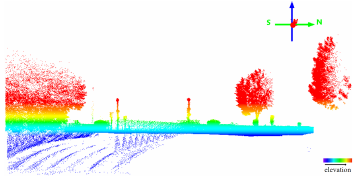
Figure 5. Projection of Figure 1a on the